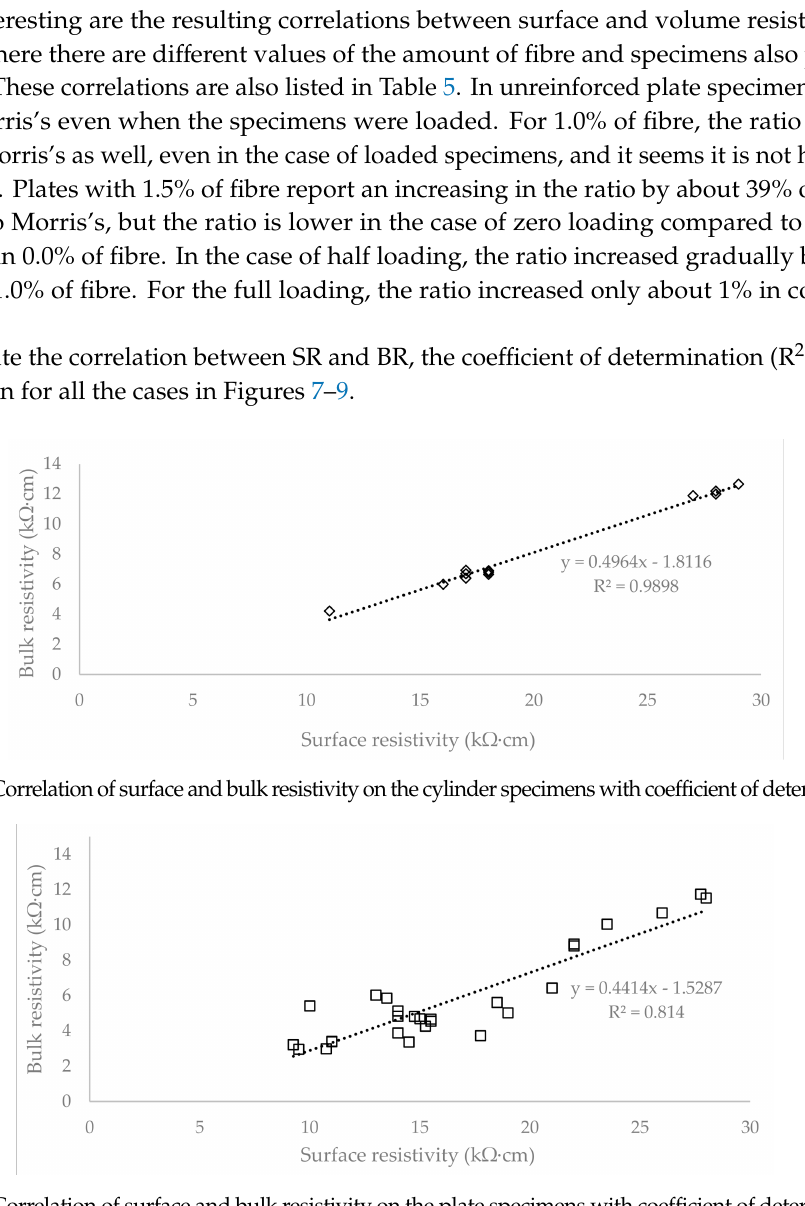
Figure 8. Correlation of surface and bulk resistivity on the plate specimens with coefficient of